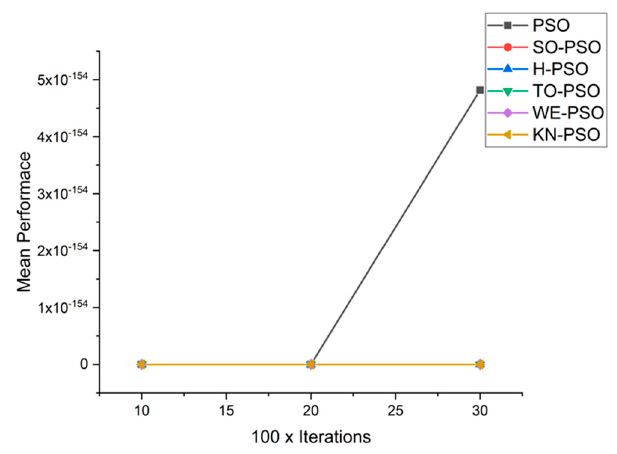
Figure 16. Convergence curve on fn10.